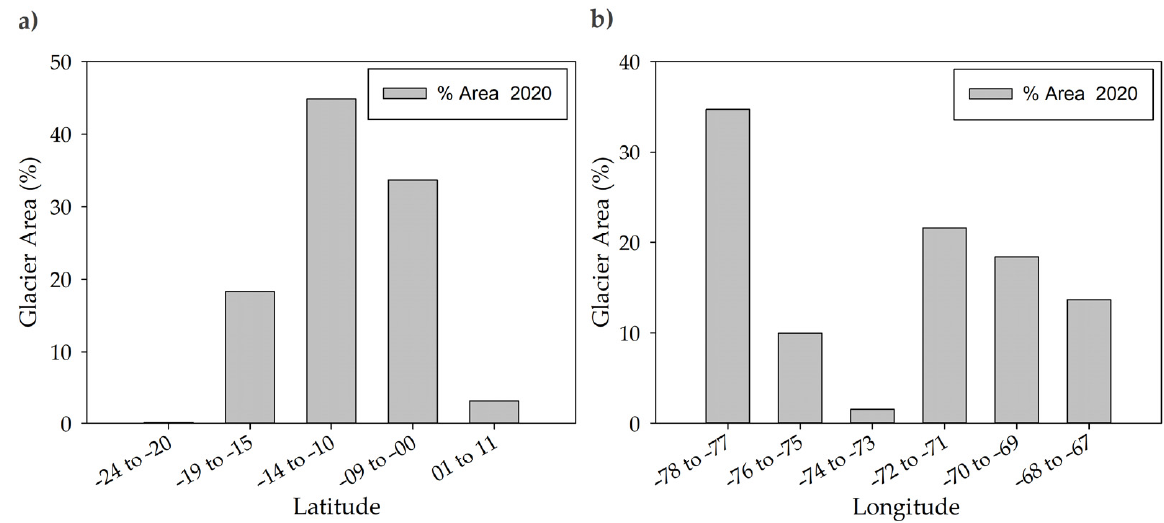
Figure 11. TAGs results for the year 2020: ( a ) spatial distribution of glaciers by latitude, and ( b ) longitude.